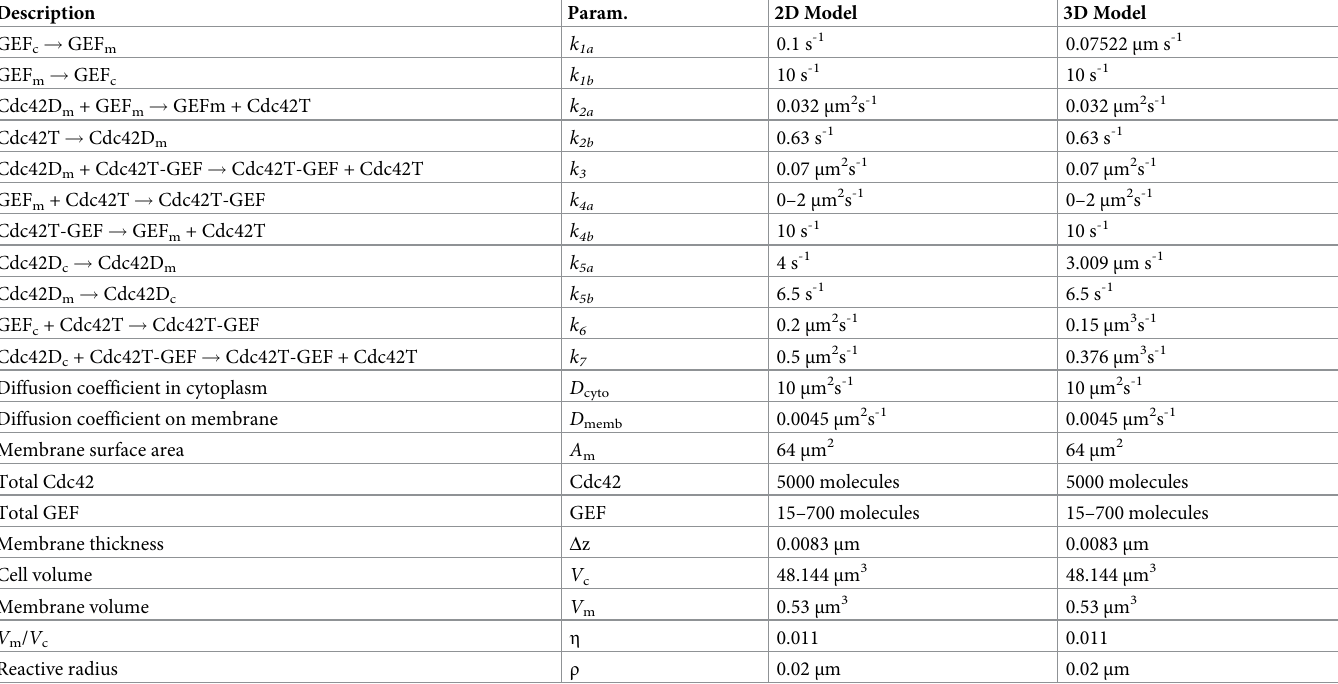
Table 1. Model parameters. For reactions, the values listed are for microscopic rate constants. For second-order reactions, the corresponding λ values can be calculated from Eqs 2 or 26, depending on the type of reaction. The parameters k h , k hd , k c and k cd used in spatial Gillespie simulations are computed from Eqs 8, 13, 16 and 19, respec- tively. The parameters for the 3D model correspond with the 2D parameters, except when they have been scaled to account for dimensionality (Methods). Both 2D and 3D particle-based simulations were performed using Smoldyn [22,23] specifying reaction probabilities for second-order interactions. Such probabilities are computed from the rate constants presented here as described in the